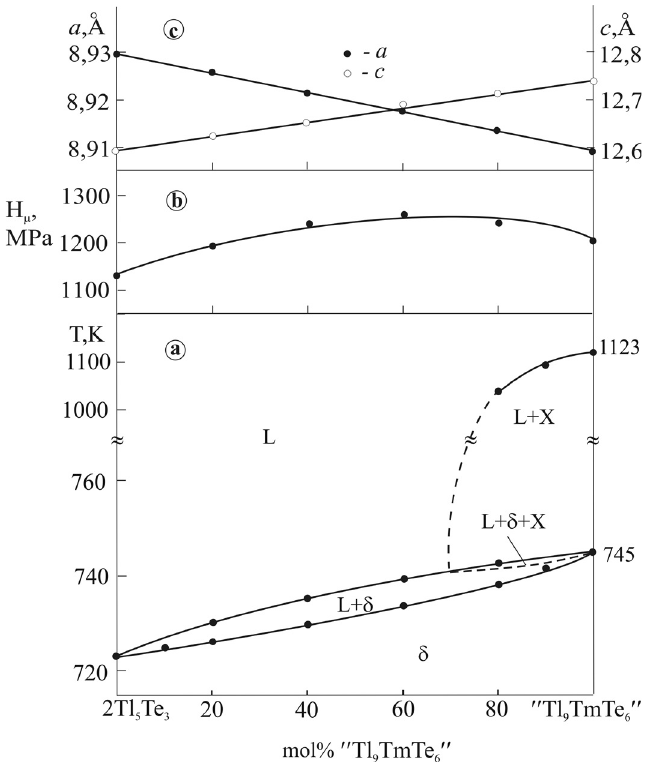
Figure 1. Phase diagram (a), concentration relations of microhardness (b), and lattice parameters (c) for the 2Tl